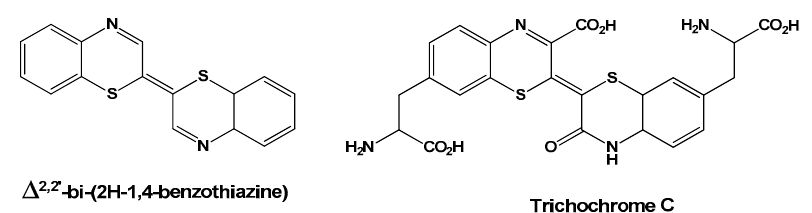
Figure 1. Representative structures of trichochromes.